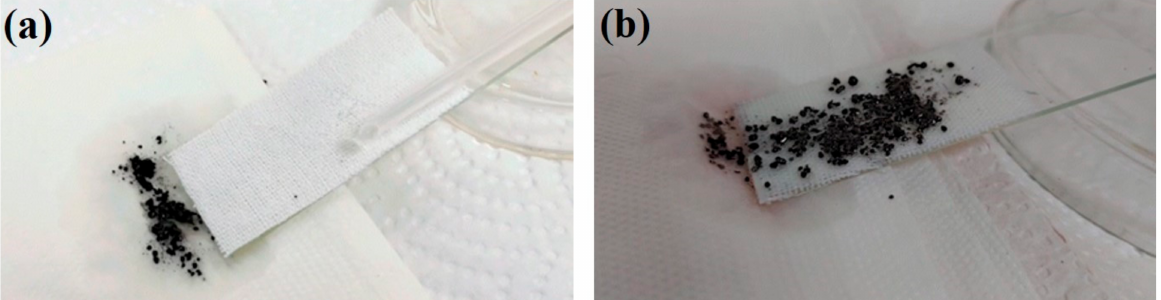
Figure 6. Self-cleaning property of the ( a ) EPS@textile and ( b ) bare textile against carbon black